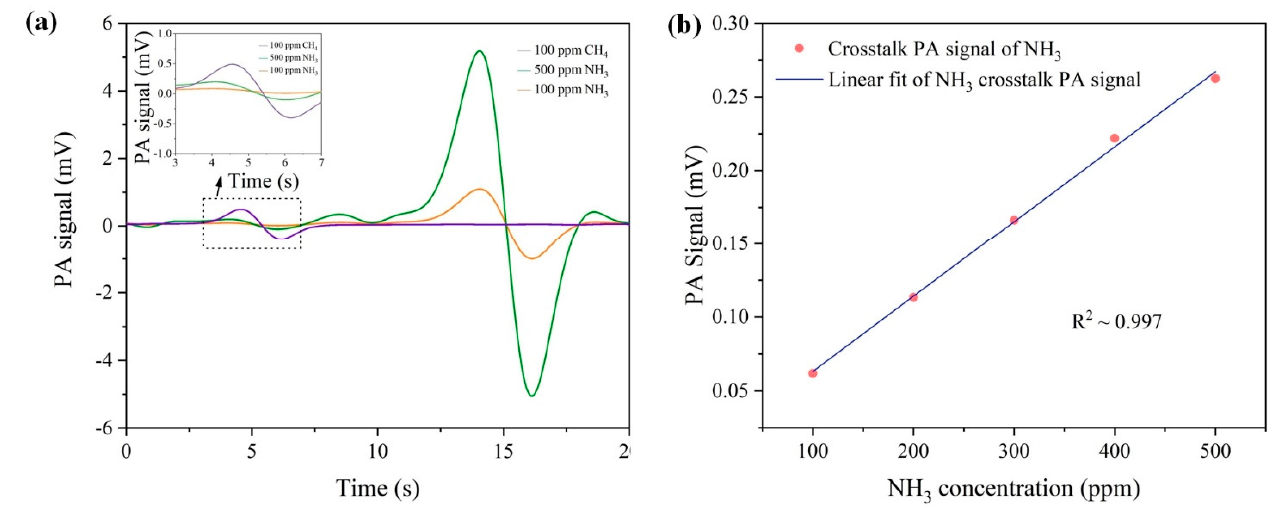
Figure 7. ( a ) Combination of NH 3 and CH 4 PAS under one scan cycle of DFB laser diodes. The purple line is 100 ppm CH 4 without NH 3 detected by DFB 2, while the green line and yellow line mark the PA spectrum of NH 3 without CH 4 detected by DFB 1. ( b ) Response linearity of the crosstalk signal induced by NH 3 at different concentrations.